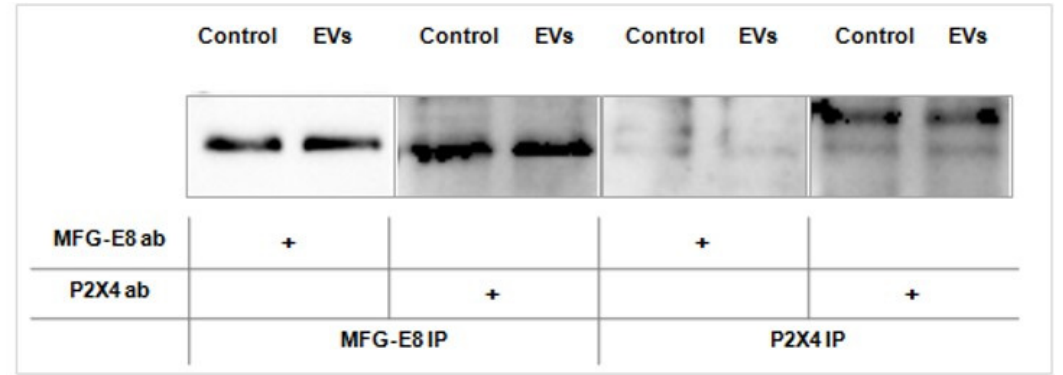
Figure 6. Co-immunoprecipitation of MFG-E8 and P2X4. Representative Western blots showing co-immunoprecipitation of MFG-E8 and P2X4R proteins in human microglial cells treated (or not) with EVs for 2 h, + indicates treatment with appropriate antibody. Full blots are available in Supplementary Figure S4.